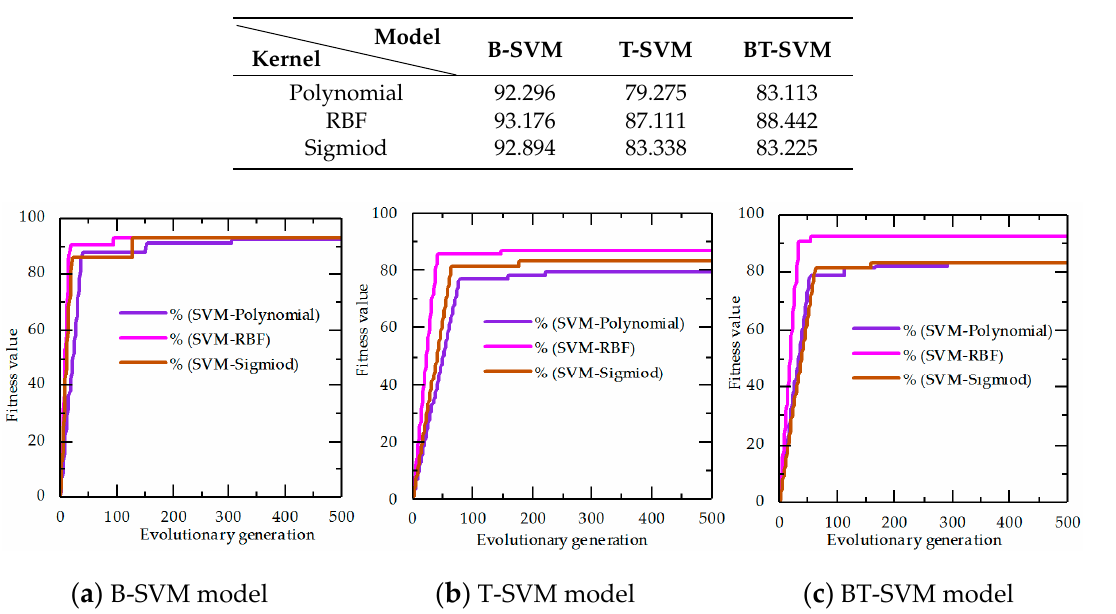
Table 4. Training classification accuracy of SVMs/% with different kernel functions.